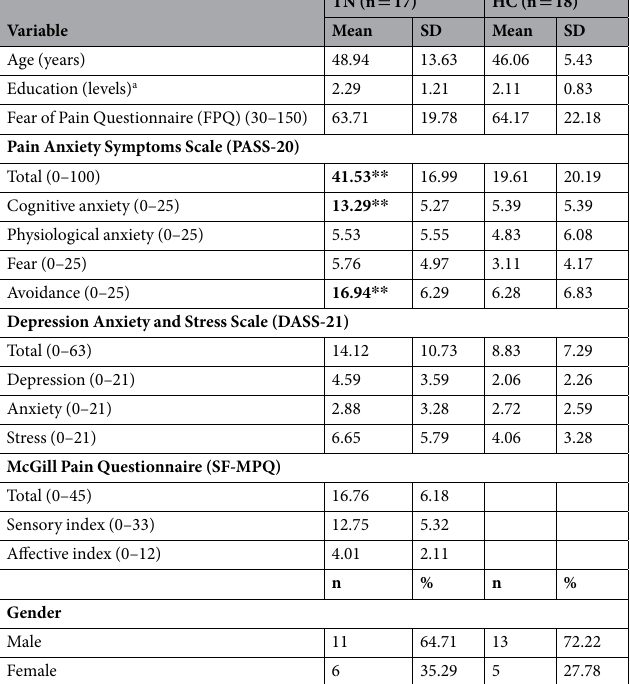
Table 1. Demographic information and neuropsychological measurement scores in experiment 1. a The level of education is measured by the grading method, 1 represents the lowest degree (primary school), 7 represents the highest degree (doctor degree). ** P < 0.01 for TN vs. HC. TN, Trigeminal neuralgia patients; HC, healthy